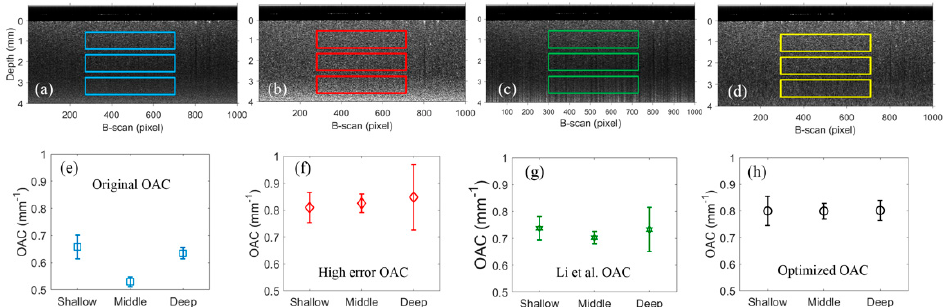
20 of 26 Figure 6. Phantom experiment results. ( a ) Logarithmic OCT B-scan image of the phantom. ( b ) Ex- ponential fi tt ing result of a typical A-scan (shown by the orange solid line in ( a )). ( c ) Original OAC image calculated from ( a ). ( d ) Original OAC curve at the position of the yellow line. ( e ) High-error OAC image. The fl uctuations range of the tail OAC has increased signi fi cantly (Red oval). ( f ) High- error OAC curve. ( g ) OAC image calculated using Li et al.’s algorithm. Bright (dark) streak artifacts appear in deep regions of the image (shown in the green box). ( h ) The OAC curve obtained using Li et al.’s algorithm, with an average value of 0.72. There is a slight underestimation of the OAC in the middle region (green arrow). ( i ) The optimized OAC image. ( j ) The optimized OAC curve. In order to show the accuracy and stability of the algorithm more intuitively, we ex- tract rectangular regions from the shallow, middle, and deep layers of the image, and cal- culate the mean and standard deviation of the OAC within the region. Figure 7a–d shows the OAC images obtained using four methods and the regions to be detected. Since phan- tom is a homogeneous medium, the OAC of the three regions should have been close (approximately equal to 0.81), and the standard deviation should have been within an appropriate range. However, Figure 7e shows that the OAC values of the three regions are all much less than 0.81. In Figure 7f, although the average values of the three regions are close to 0.81, the standard deviation of the OAC in deep tissue can be seen to have